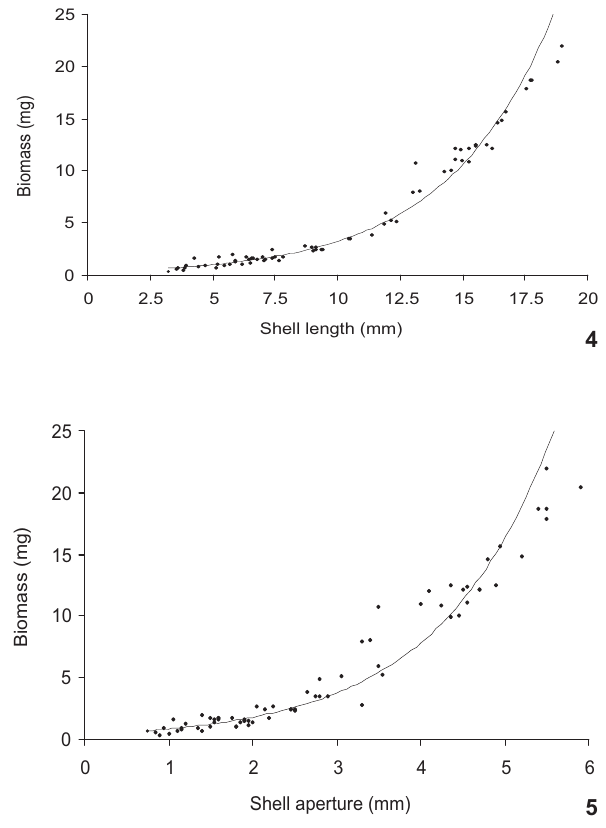
Figures 4-5. Graphs of exponential regression model for biomass/ shell length (4) and biomass/shell aperture (5) of M.